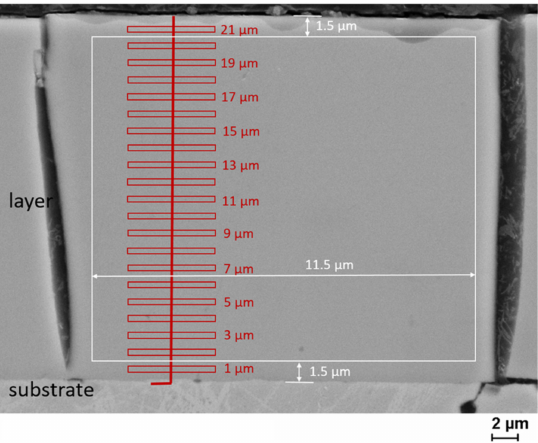
Figure 1. Method of area analysis (white) and method of point analysis (red) of EDXS